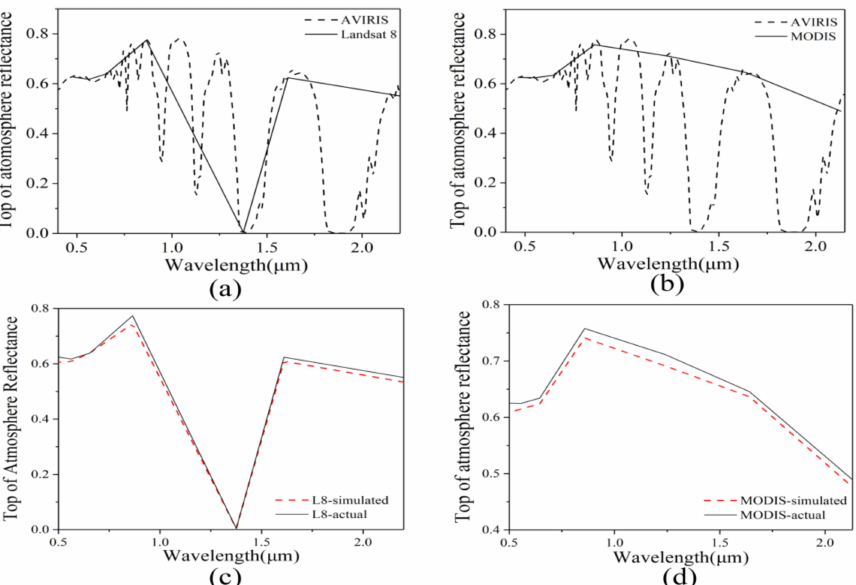
Figure 4. Comparison of actual cloud pixel spectrum and simulated cloud pixel spectrum: ( a ) actual cloud pixel spectrum from AVIRIS image and simulated cloud pixel spectrum of Landsat-8; ( b ) actual cloud pixel spectrum from AVIRIS image and simulated cloud pixel spectrum of MODIS; ( c ) actual cloud pixel spectrum from Landsat-8 image and simulated cloud pixel spectrum of Landsat-8; ( d ) actual cloud pixel spectrum from MODIS image and simulated cloud pixel spectrum of